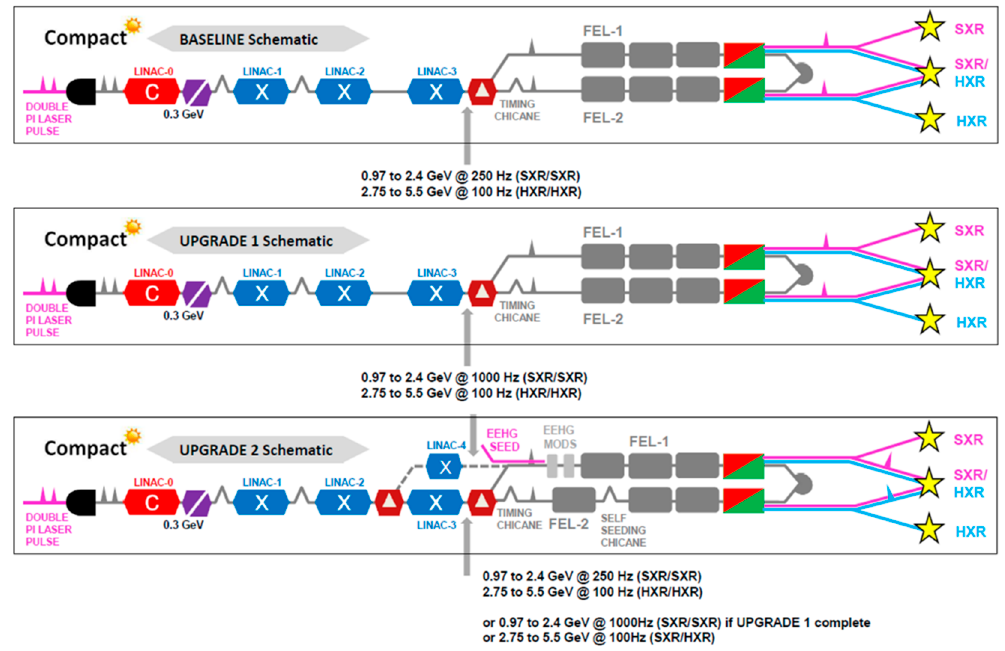
Figure 2. CompactLight layout (not to scale) for the baseline and upgraded footprints, see text for details.